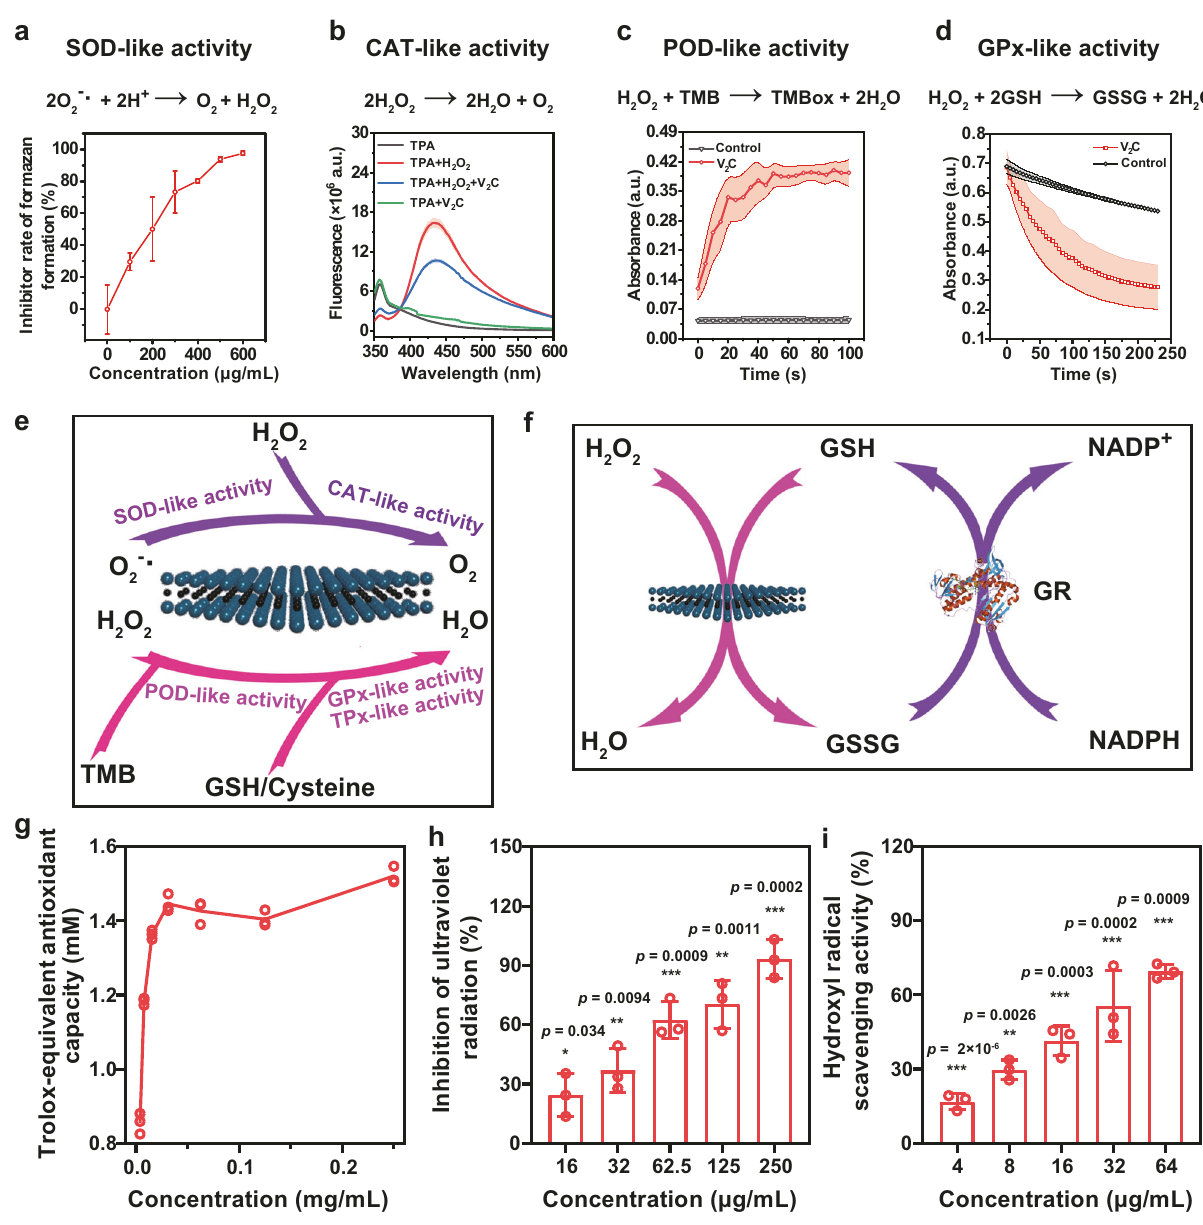
Fig. 4 Multiple enzyme-mimicking activities of 2D V 2 C MXenzyme. a SOD-like activity of V 2 C MXenzyme ( n = 3 for each group). b CAT-like activity of V 2 C MXenzyme ( n = 3 for each group). c POD-like activity of V 2 C MXenzyme ( n = 3 for each group). d GPx-like activity of V 2 C MXenzyme ( n = 3 for each group). e Schematic illustration of enzyme-mimicking activities of V 2 C MXenzyme. f Schematic representation exemplifying GPx-like activity of V 2 C MXenzyme and GSH recycling by GR. g Total antioxidant capacity of V 2 C MXenzyme ( n = 3 for each group). h Ultraviolet radiation-inhibition activity of V 2 C MXenzyme ( n = 3 for each group). i Hydroxyl radical-scavenging activity of V 2 C MXenzyme ( n = 3 for each group). Data presented as mean ± SD, and asterisks indicate a signi fi cant difference (* p < 0.05, ** p < 0.01, and *** p < 0.001) as compared with the control group using one-way analysis of variance